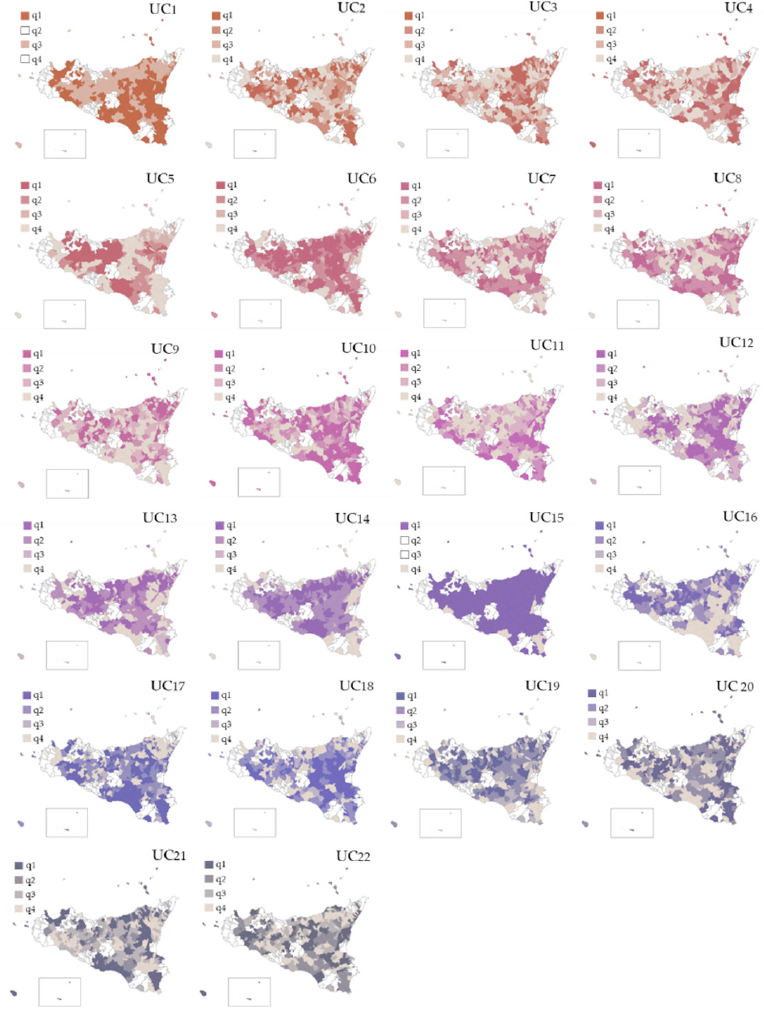
Figure 10. Mapping Urban Capital Indicators. (Authors’ elaboration.) With reference to the second quartile, Figure 10 shows: the presence of clusters of municipalities predominantly falling in the north-central area of Sicily for UC1; small clus- ters of municipalities predominantly falling in the northern and southern areas of Sicily for UC2; small clusters of municipalities predominantly falling in the eastern area of Sicily for UC3, UC4 and UC5; clusters of municipalities predominantly falling in the central area of Sicily for UC6, UC7 and UC8; small clusters of municipalities predominantly falling in the central area of Sicily for UC9 and UC10; small clusters of municipalities predominantly falling in the southern area of Sicily for UC11; clusters of municipalities predominantly falling in the central area of Sicily for UC12, UC13, and UC14; no municipalities in the second quartile for UC15; and small clusters of municipalities predominantly falling in the north-central area of Sicily for UC16, UC17, UC18, UC19, UC20, UC21, and UC22. With reference to the third quartile, Figure 10 shows: no municipalities in the third quartile for UC1; small clusters of municipalities predominantly falling in the central area of Sicily for UC2, UC3, UC4, and UC5; small clusters of municipalities predominantly fall- ing in the southern area of Sicily for UC6; small clusters of municipalities predominantly falling in the central area of Sicily for UC7, UC8, UC9, UC10, and UC11; small clusters of municipalities predominantly falling in the southern and eastern area of Sicily for UC12; small clusters of municipalities predominantly falling in the eastern area of Sicily for UC13; small clusters of municipalities predominantly falling in the central area of Sicily for UC14; no municipalities in the second third for UC15; small clusters of municipalities predominantly falling in the central area of Sicily for UC16, UC17, UC18, UC19, UC20, UC21, and UC22. With reference to the fourth quartile, Figure 10 shows: no municipalities in the sec- ond quartile for UC1; clusters of municipalities predominantly falling in the central and